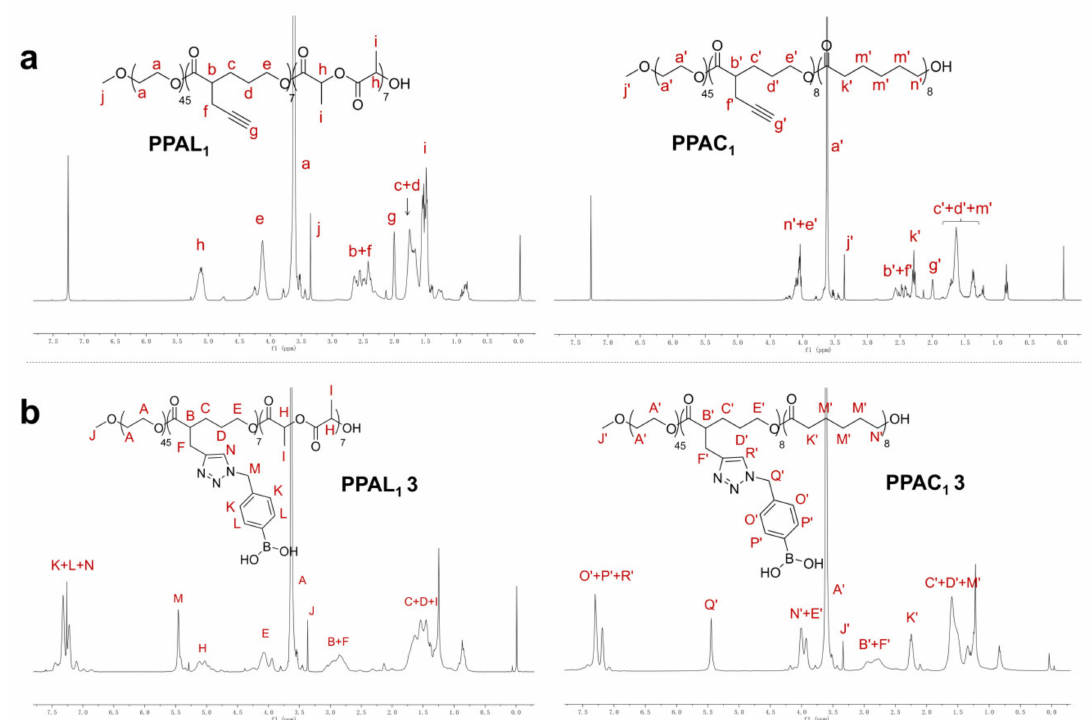
Figure 1. The representative 1 H NMR of PPAL 1 and PPAC 1 copolymers ( a ); PPAL 1 3 and PPAC 1 3 copolymers ( b ). As the final applications of copolymer PPLA or PPAC in drug delivery systems can be significantly affected by its monomer ratio and sequence [48], the living characteristics of the polymerization of D,L-LA and AVL monomers initiated by mPEG 2K (conditions: [mPEG 2K ] = 0.25 mM, [mPEG 2K ]:[D,L-LA]:[AVL] = 1:7.5:14.5) were investigated and moni- tored by 1 H NMR (in CDCl 3 ) and gas chromatography (GC) (in DCM). As revealed in 1 H NMR spectra (Figure 2a), the characteristic peaks of D,L-LA and AVL monomers gradually disappeared, which indicated that both of the two monomers were consumed simulta- neously in polymerization process. Additionally, the progressive formation of resulting copolymers was confirmed (peaks of c and d in Figure 2a). Furthermore, quantitative monitoring of the polymerization of D,L-LA and AVL monomers was determined by GC within 48 h. As shown in Figure 2b, both of two monomers were consumed simultaneously. Compared with AVL, the reactivity of the D,L-LA monomer was higher during the copoly- merization process, which might be attributed to the presence of more bulky alkynyl in AVL. As a result, in order to achieve a fairly random copolymer, the feed ratio of AVL in the initial of copolymerization should be higher than in the designed copolymer. In our case, the monomer ratio of D,L-LA to AVL in the formed copolymer chain was basically consistent at a different reaction time and finally a random copolymer chain was obtained when the feed ratio of AVL is 1.9 times that of D,L-LA. Moreover, a linear